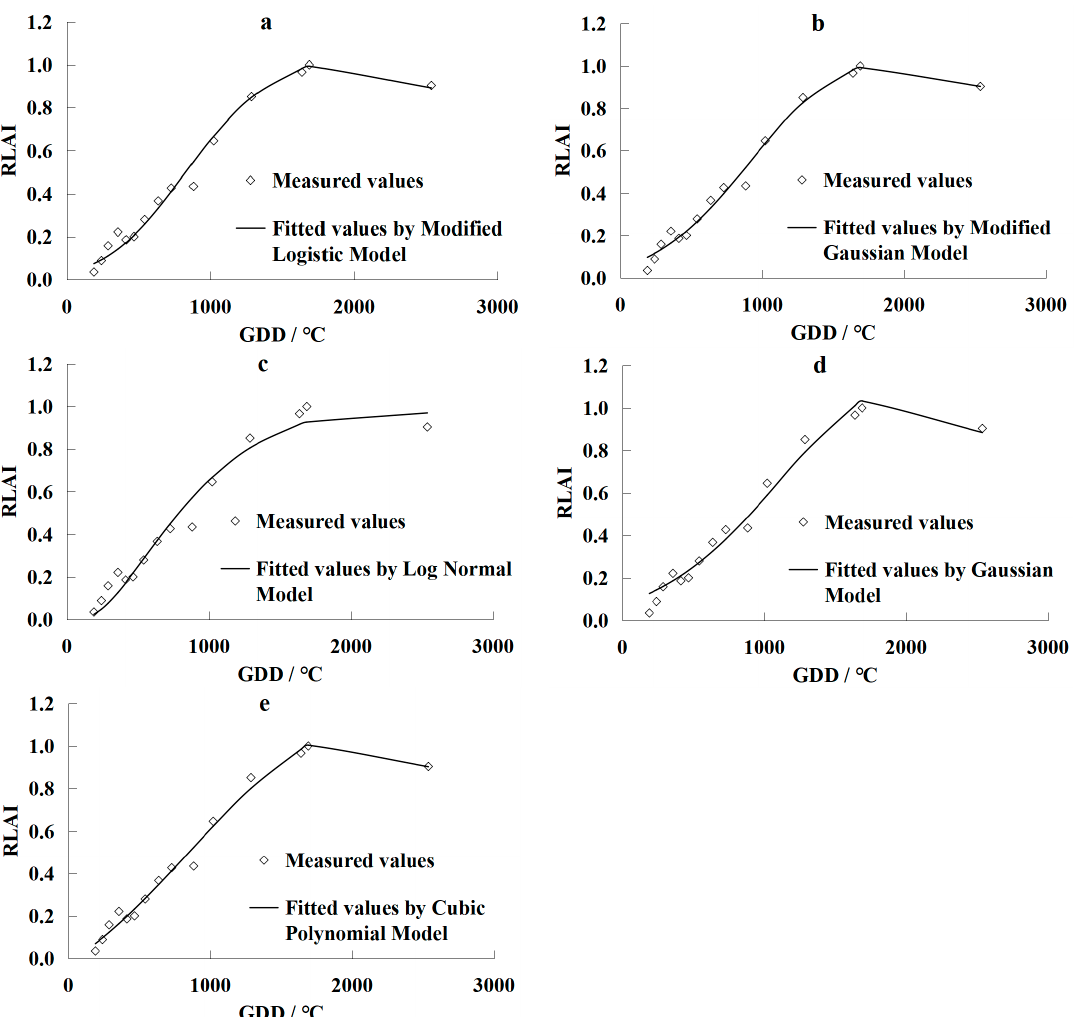
Figure 5. Comparisons of the measured and simulated mean relative leaf area index (RLAI): ( a ) modified Logistic model; ( b ) modified Gaussian model; ( c ) log-normal model; ( d ) Gaussian model; ( e ) cubic polynomial model. Measured values are the average RLAI values of six treatments, and simulated values are calculated by the five models and growing degree days (GDD).